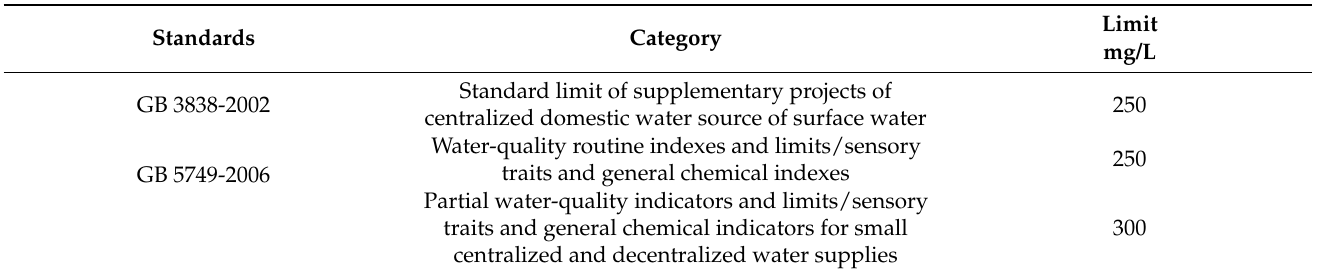
Table 3. Comparison of the water-quality limits and emission limits for chloride in China’s current